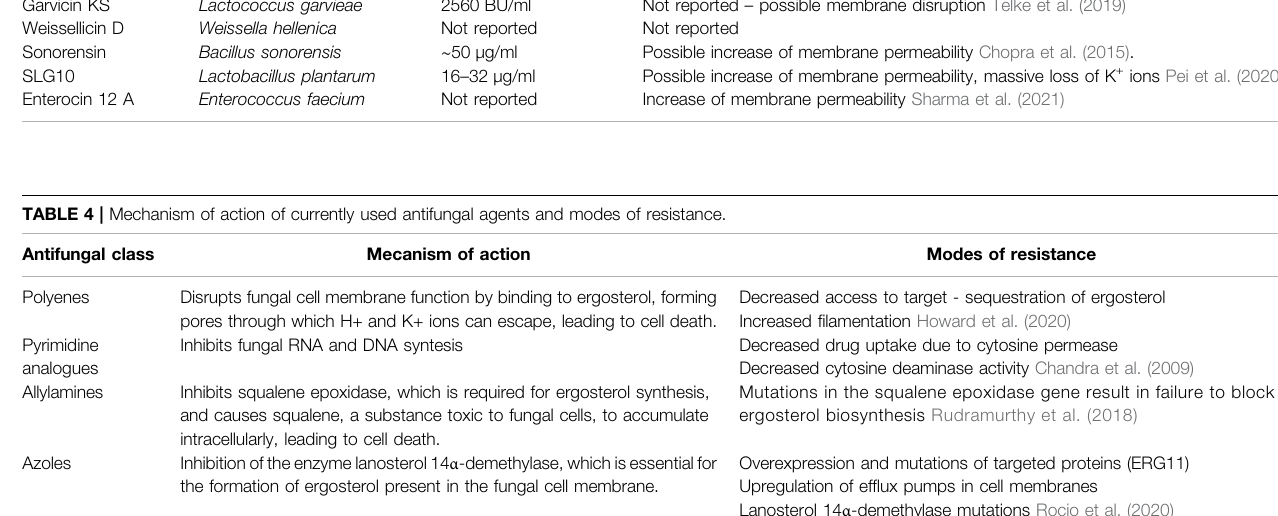
TABLE 3 | Mechanism of action of antibacterial compounds of bacterial origin against Gram-negative strains. Compound